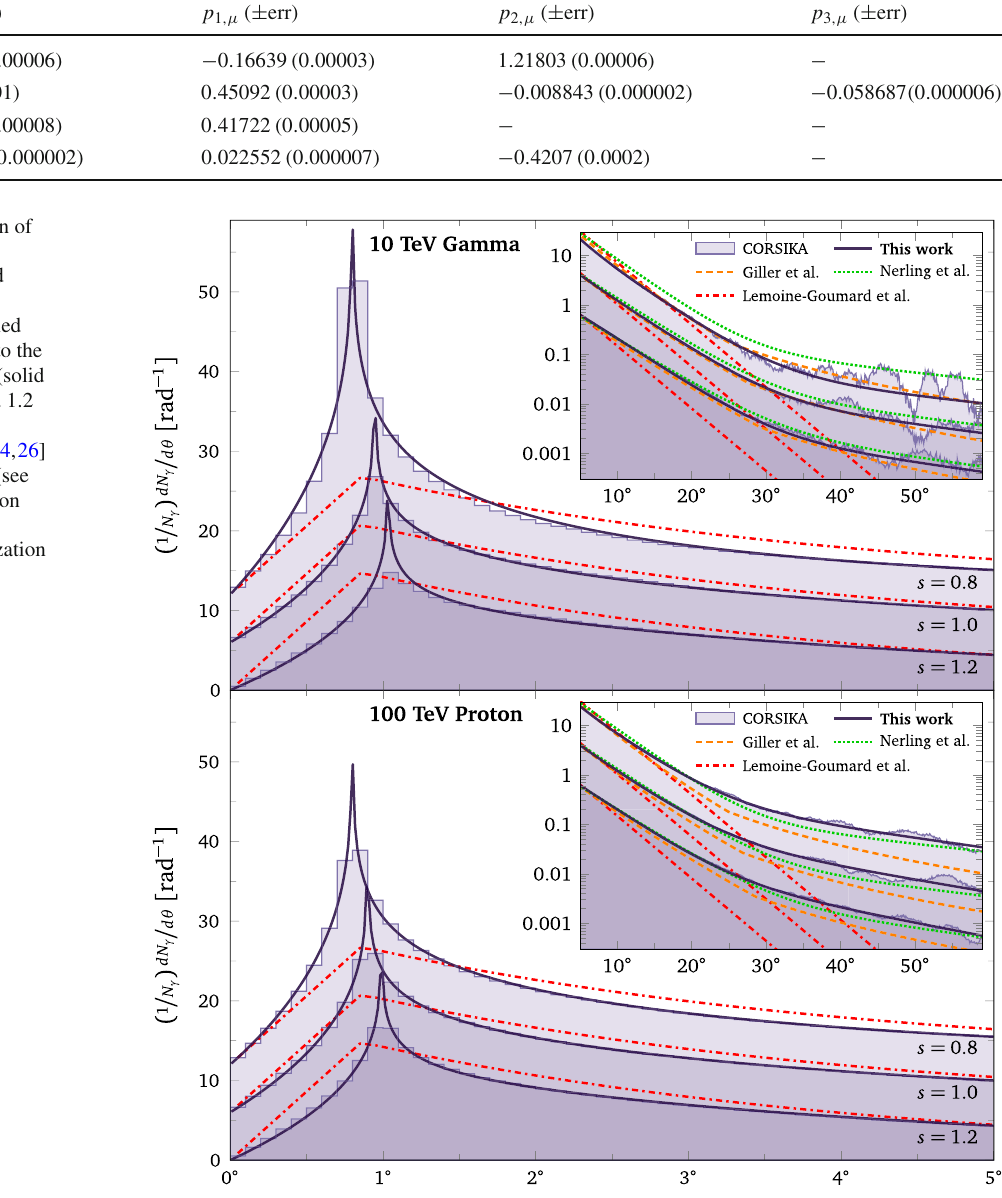
Table 2 Coefficients describing the angular distribution of Cherenkov photons in proton air showers